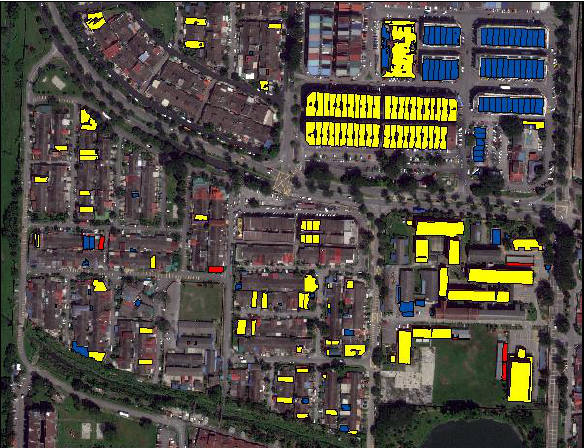
Figure 4: Roofing material with new